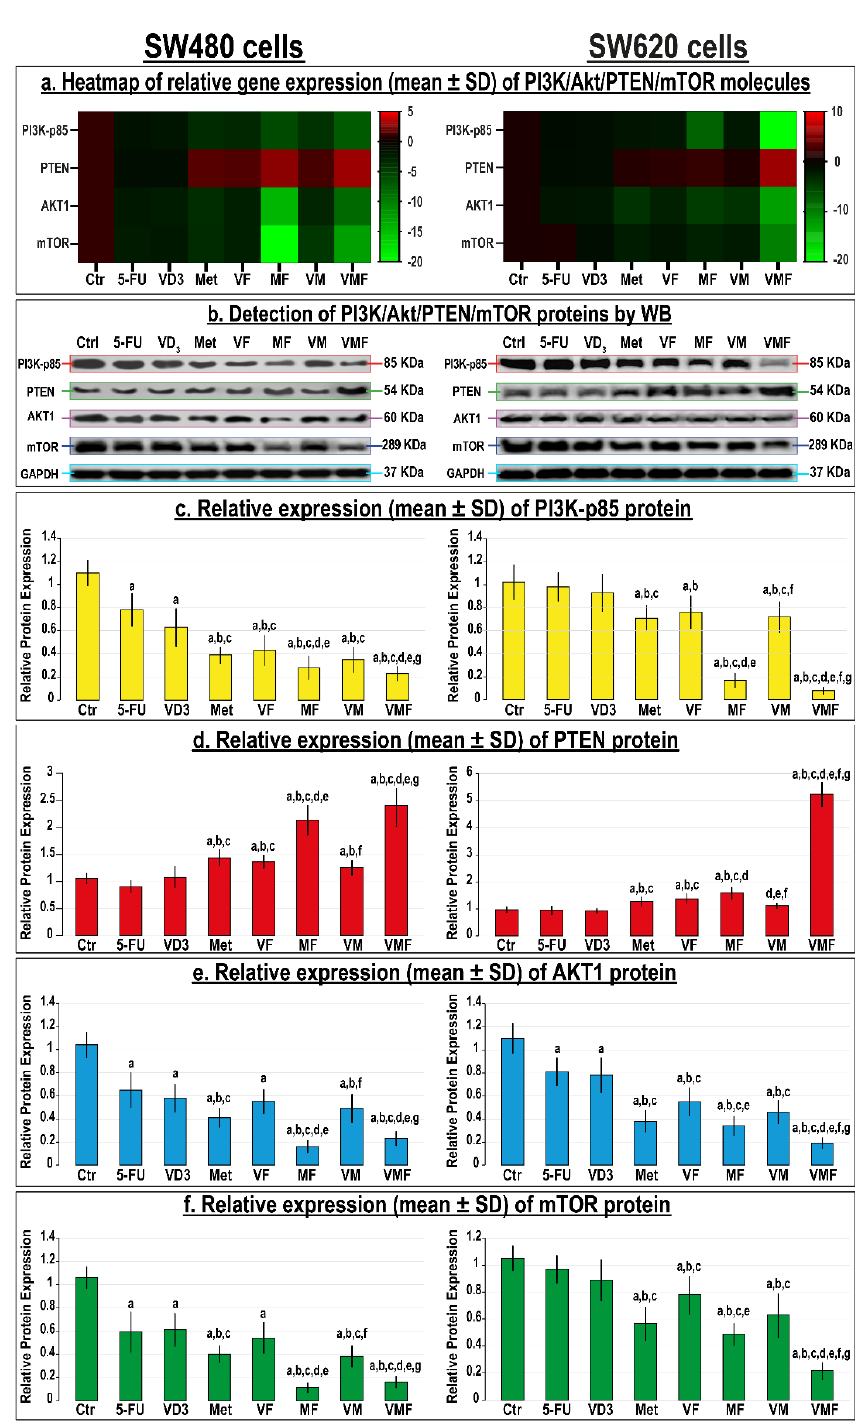
Figure 9. ( a ) Heatmap showing relative mRNA expression (mean ± SD) of PI3K-p85 α , PTEN, Akt1, and mTOR genes alongside ( b ) detection of their proteins by Western blot and ( c – f ) their relative protein expression (mean ± SD) following treatments with 5-fluorouracil, calcitriol, and/or metformin single (5-FU, VD 3 , and Met), dual (VF, MF, and VM), and triple (VMF) therapies for 12 h in the SW480 and SW620 colon cancer cell lines (n = 3/group; data were analysed by ANOVA followed by Games–Howell post hoc tests and are shown as the mean ± SD; a = p < 0.05 compared with control untreated cells; b = p < 0.05 compared with 5-FU monotherapy; c = p < 0.05 compared VD 3 monotherapy; d = p < 0.05 compared with Met monotherapy; e = p < 0.05 compared with VF dual therapy; f = p < 0.05 compared with MF dual therapy; and g = p < 0.05 compared with VM dual therapy).